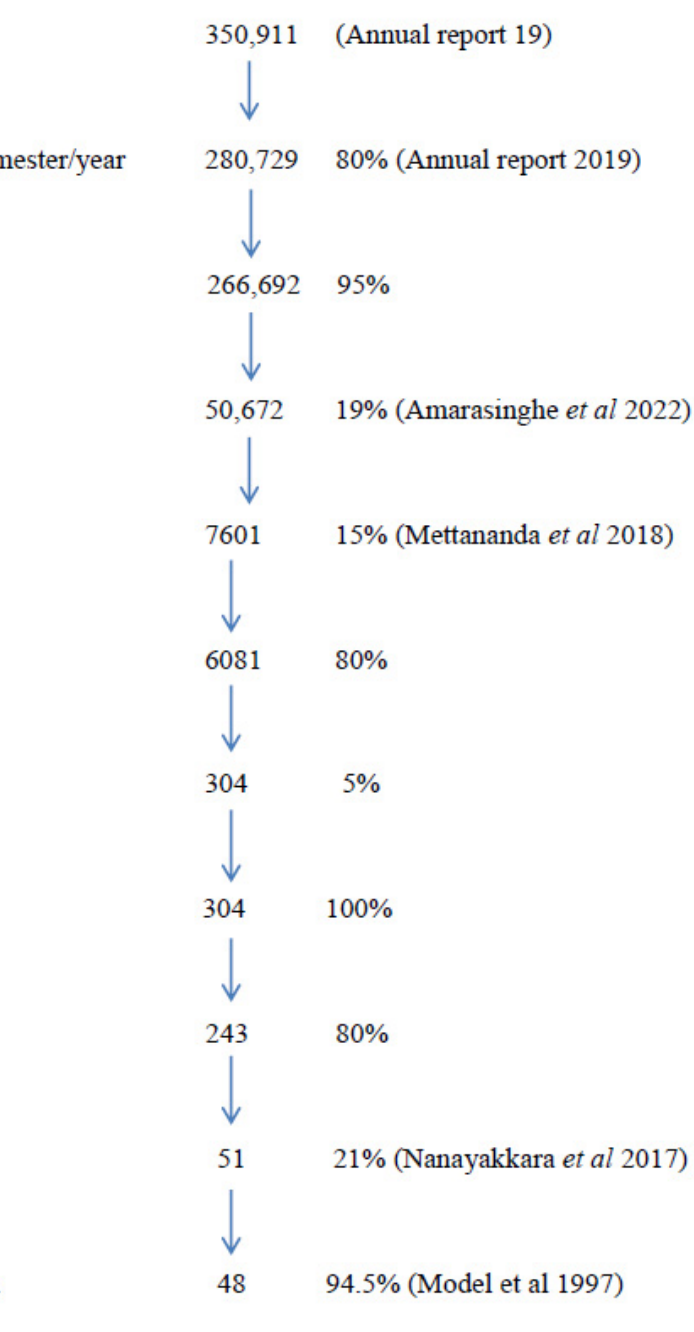
Figure 1. Calculation of the estimated number of TM births averted by policy option 3 prenatal diagnosis. Within parenthesis the references relating the data sources are given.